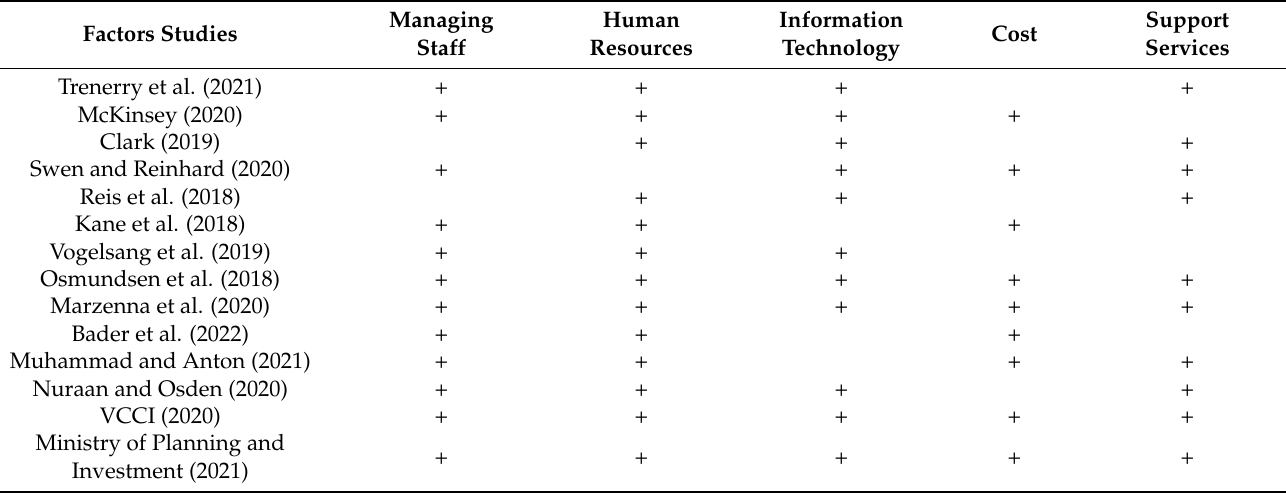
Table 1. Summary of the common factors in related